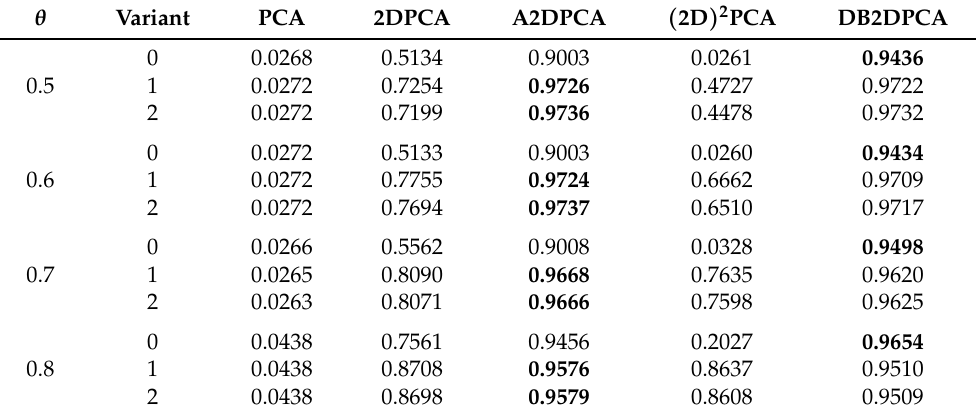
Table 8. The average classification accuracies corresponding to four thresholds on the Extended Yale B face database and its reordered and reshaped variants with CRC as the classifier.